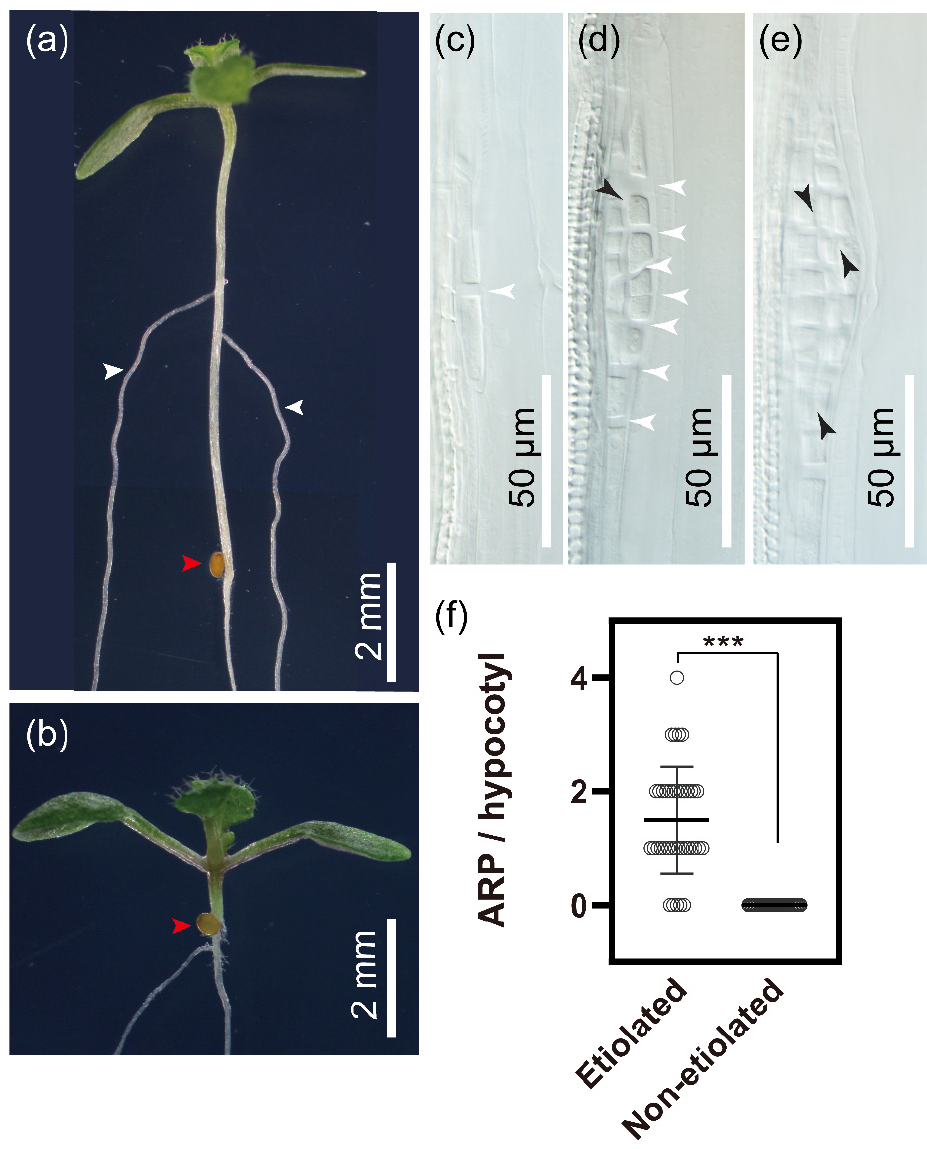
Figure 1. Adventitious root formation in etiolated and non-etiolated hypocotyls of Arabidopsis thaliana . ( a ) AR formation upon exposure to light of etiolated (7 days) Col-0, ( b ) no hypocotyl AR are formed in light grown (7 days) Col-0, (red arrowhead points to the hypocotyl root junction, scale bar: 2 mm). ( c ) Stage I ARP, ( d ) stage II ARP and ( e ) stage III ARP in cleared hypocotyls from 2 days de-etiolated seedlings. White arrowheads point to cell walls from anticlinal or oblique cell divisions; black arrowheads point to cell walls from periclinal divisions; scale bar: 50 µ m. ( f ) Adventitious root number per hypocotyl in de-etiolated and non-etiolated Col-0 seedlings. AR were quantified after 7 days in the light. The data represented as means ± SD (etiolated, n = 39; non-etiolated, n = 37). (***: p ≤ 0.001, unpaired Student’s t -test).